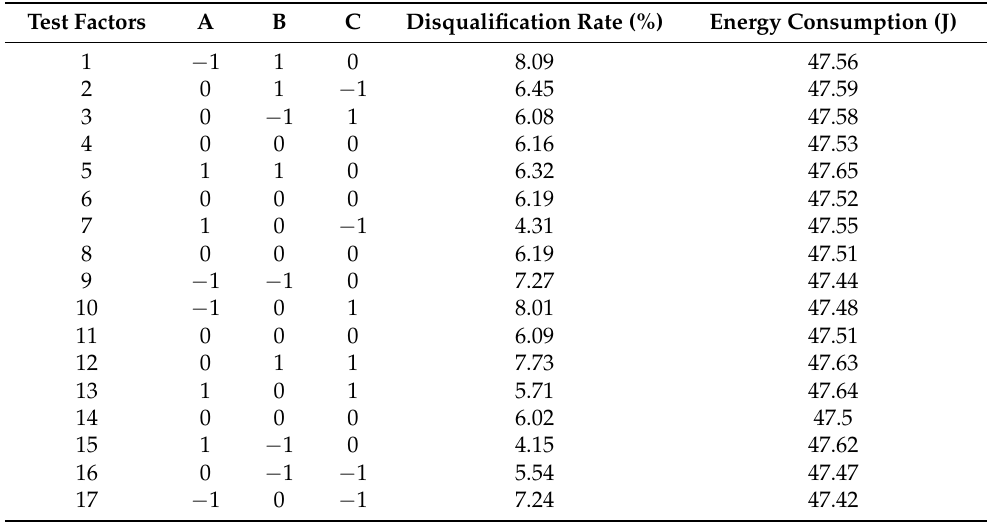
Table 3. In the table, A, B, and C are the coded values for the cutter shaft speed, cutting clearance, and cutter edge angle, respectively. Table 3. Test design scheme and results.